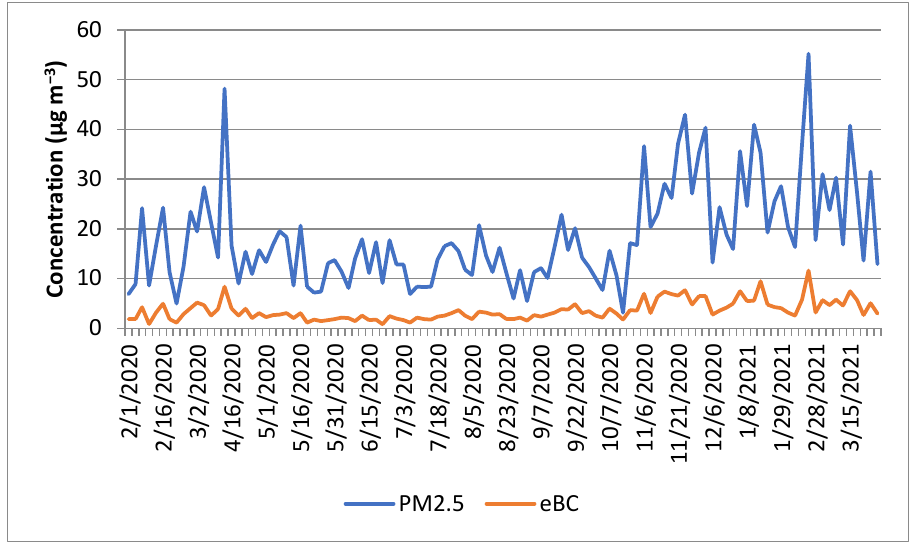
Figure 8. Daily concentrations of PM 2.5 and eBC µg m −3 .